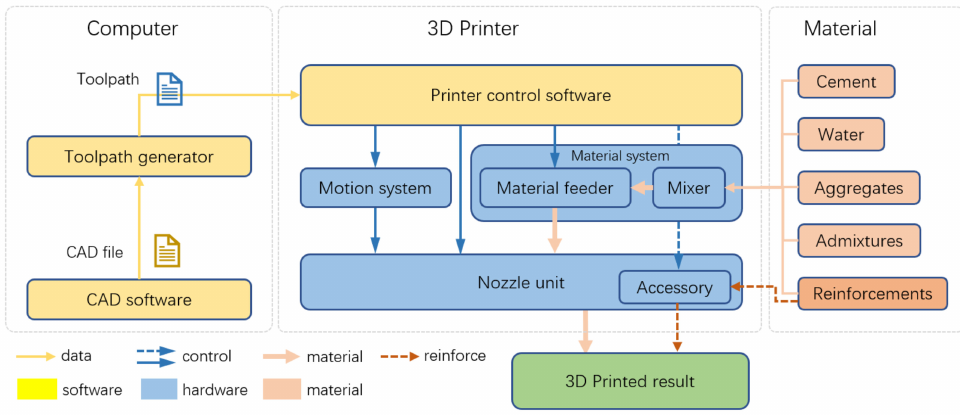
Figure 1. The 3D concrete printing